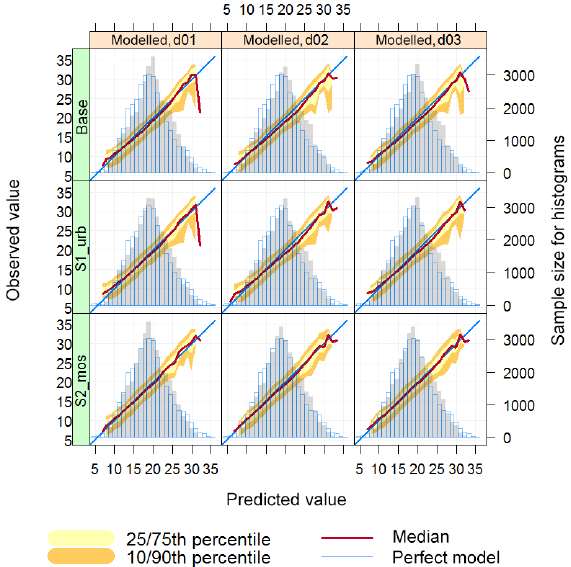
Figure 4. Conditional quantile plot of simulated and observed tem- perature ( ◦ C). The model results are split into evenly spaced bins and compared to observations spatially and temporally matching the values in the model result bins. The red line denotes the median of each of these bins. Grey bars show the distribution of model re- sults, blue outline bars the distribution of observations. The results are shown for the base run and sensitivity simulations S1_urb and S2_mos, each for all three model domains (d01 – 15km horizontal resolution, d02 – 3km, d03 –